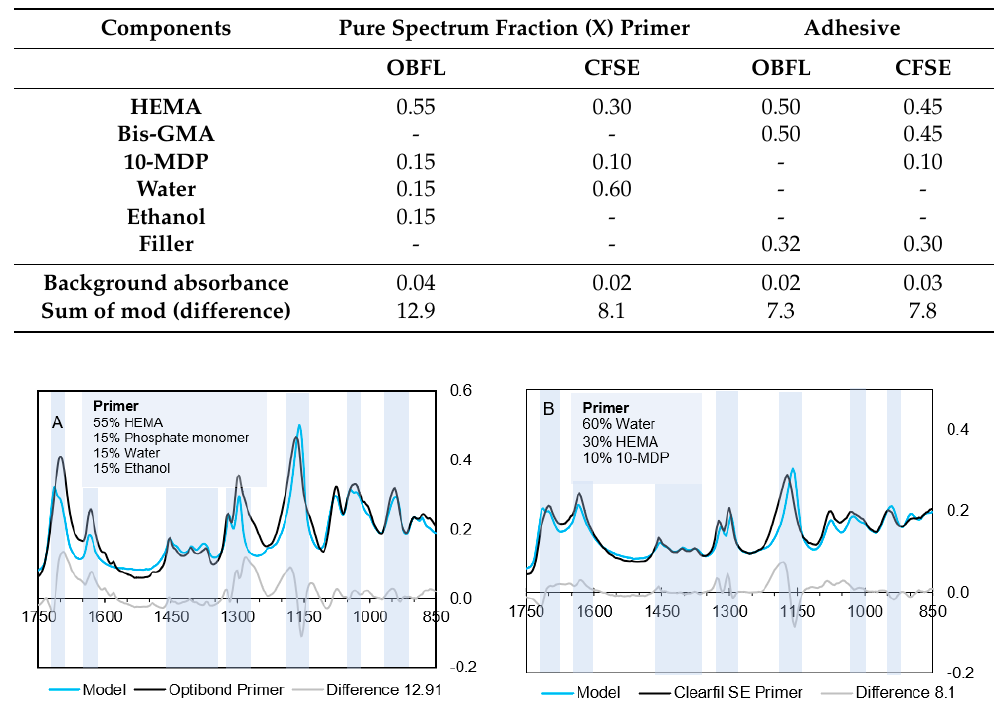
Figure 6. FTIR spectra of primers, the calculated model spectra, percentages of pure spectra used in the model, and difference between the actual spectra and model. ( A ) OBFL primer model requires a mixture of water and ethanol and a higher amount of HEMA. ( B ) The CFSE model requires a higher percentage of water. Blue bars highlighted represent common methacrylate peaks. Table 4. Summary table indicating the fractions of different spectra (X in Equation (1)) used to pro- duce the model spectra for OBFL and CFSE. Also provided is the required flat background term and the sum of the modulus of differences that indicates the quality of model fit (Equation (4)).